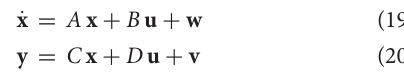
FIGURE 4 | Comparison of the PM spectrum of a wind speed v 19.5 with the ARMA calculated PM